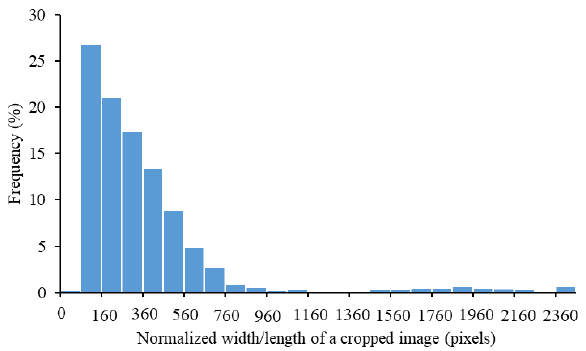
Figure 3. Frequency distribution of normalized width/length of a cropped image.